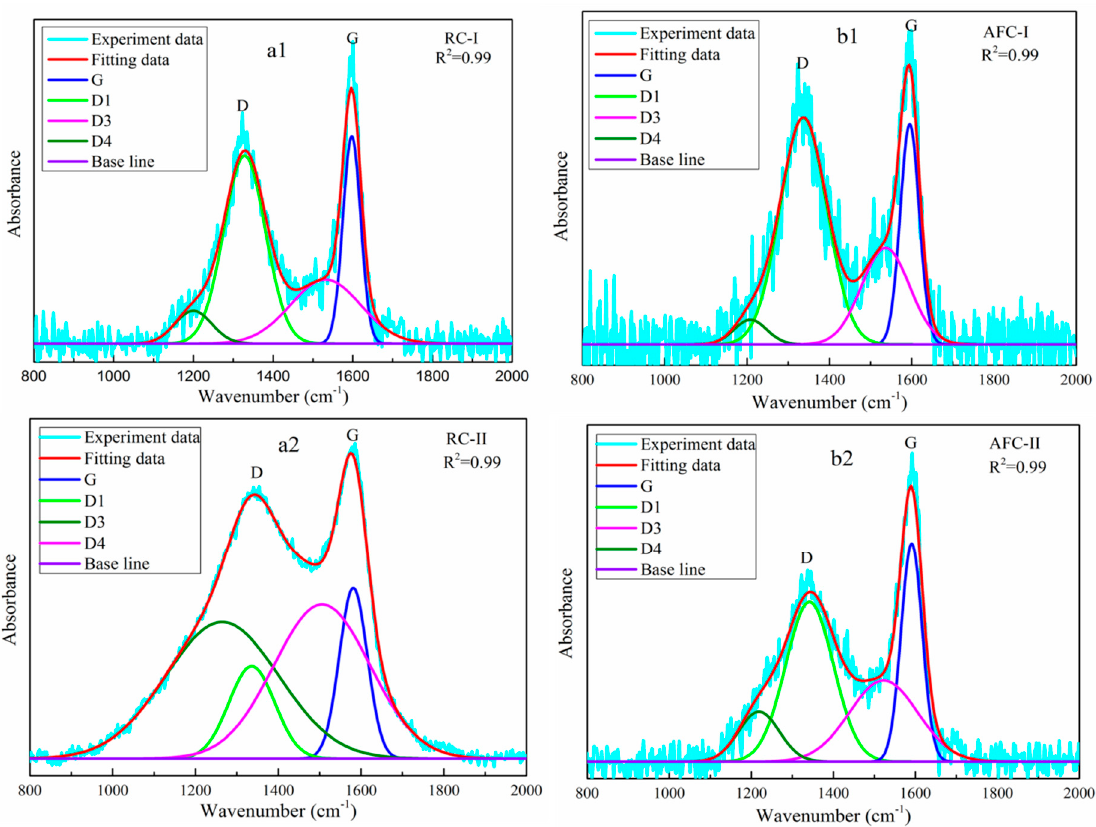
Figure 5. Typical first-order region Raman spectra and the bands of the selected samples ( a1 : RC-I; b1 : AFC-I; a2 : AFC-I; b2 : AFC-II).